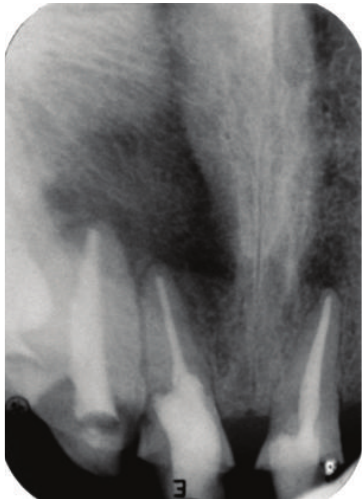
Figure 21: 12-month followup IOPA